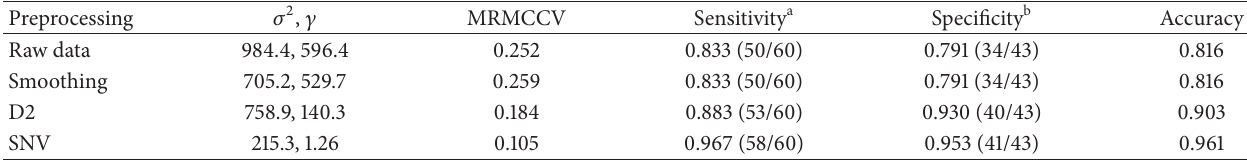
Table 3: Classification of regular and aged shiitake by LS-SVM.